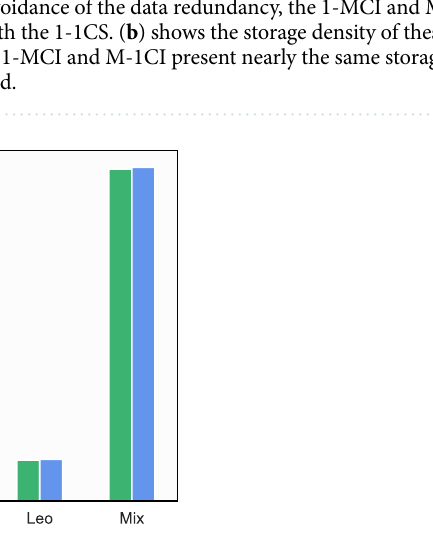
Figure 12. Time efficiency. This figure presents the time taken for the encoding and decoding process when processing different files under 1-MCI and M-1CI storage methods. Since 1-MCI and M-1CI present nearly the same time performance, therefore, the bar chart does not present different methods as one extra